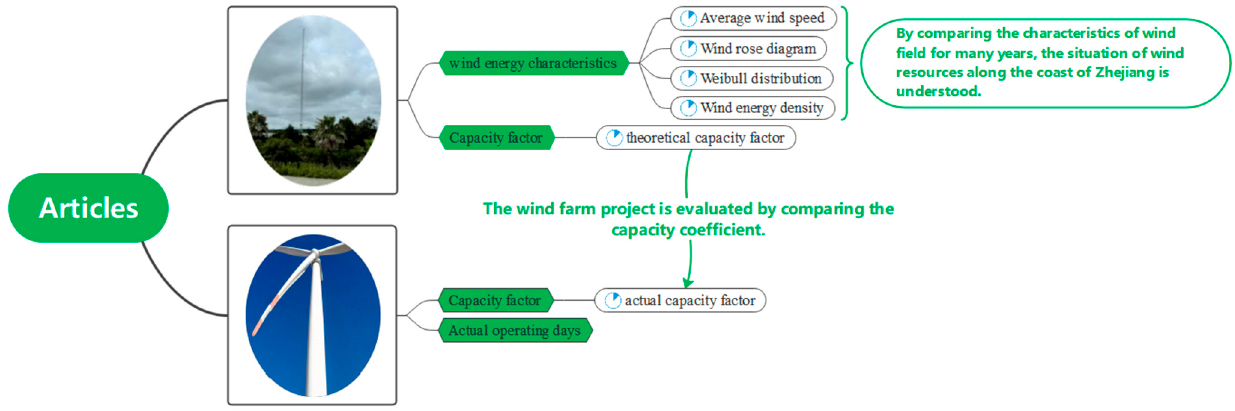
Figure 1. Main workflow of this study